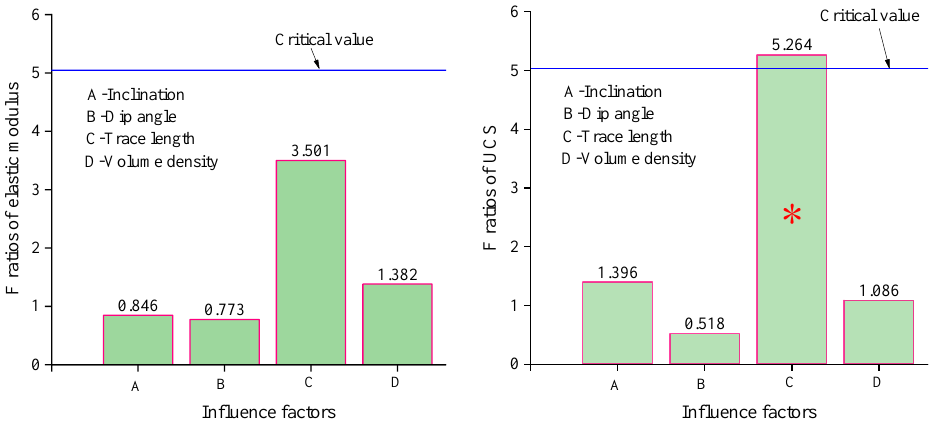
Figure 7. F ratio and significance levels of the elastic modulus and UCS under various influencing factors.